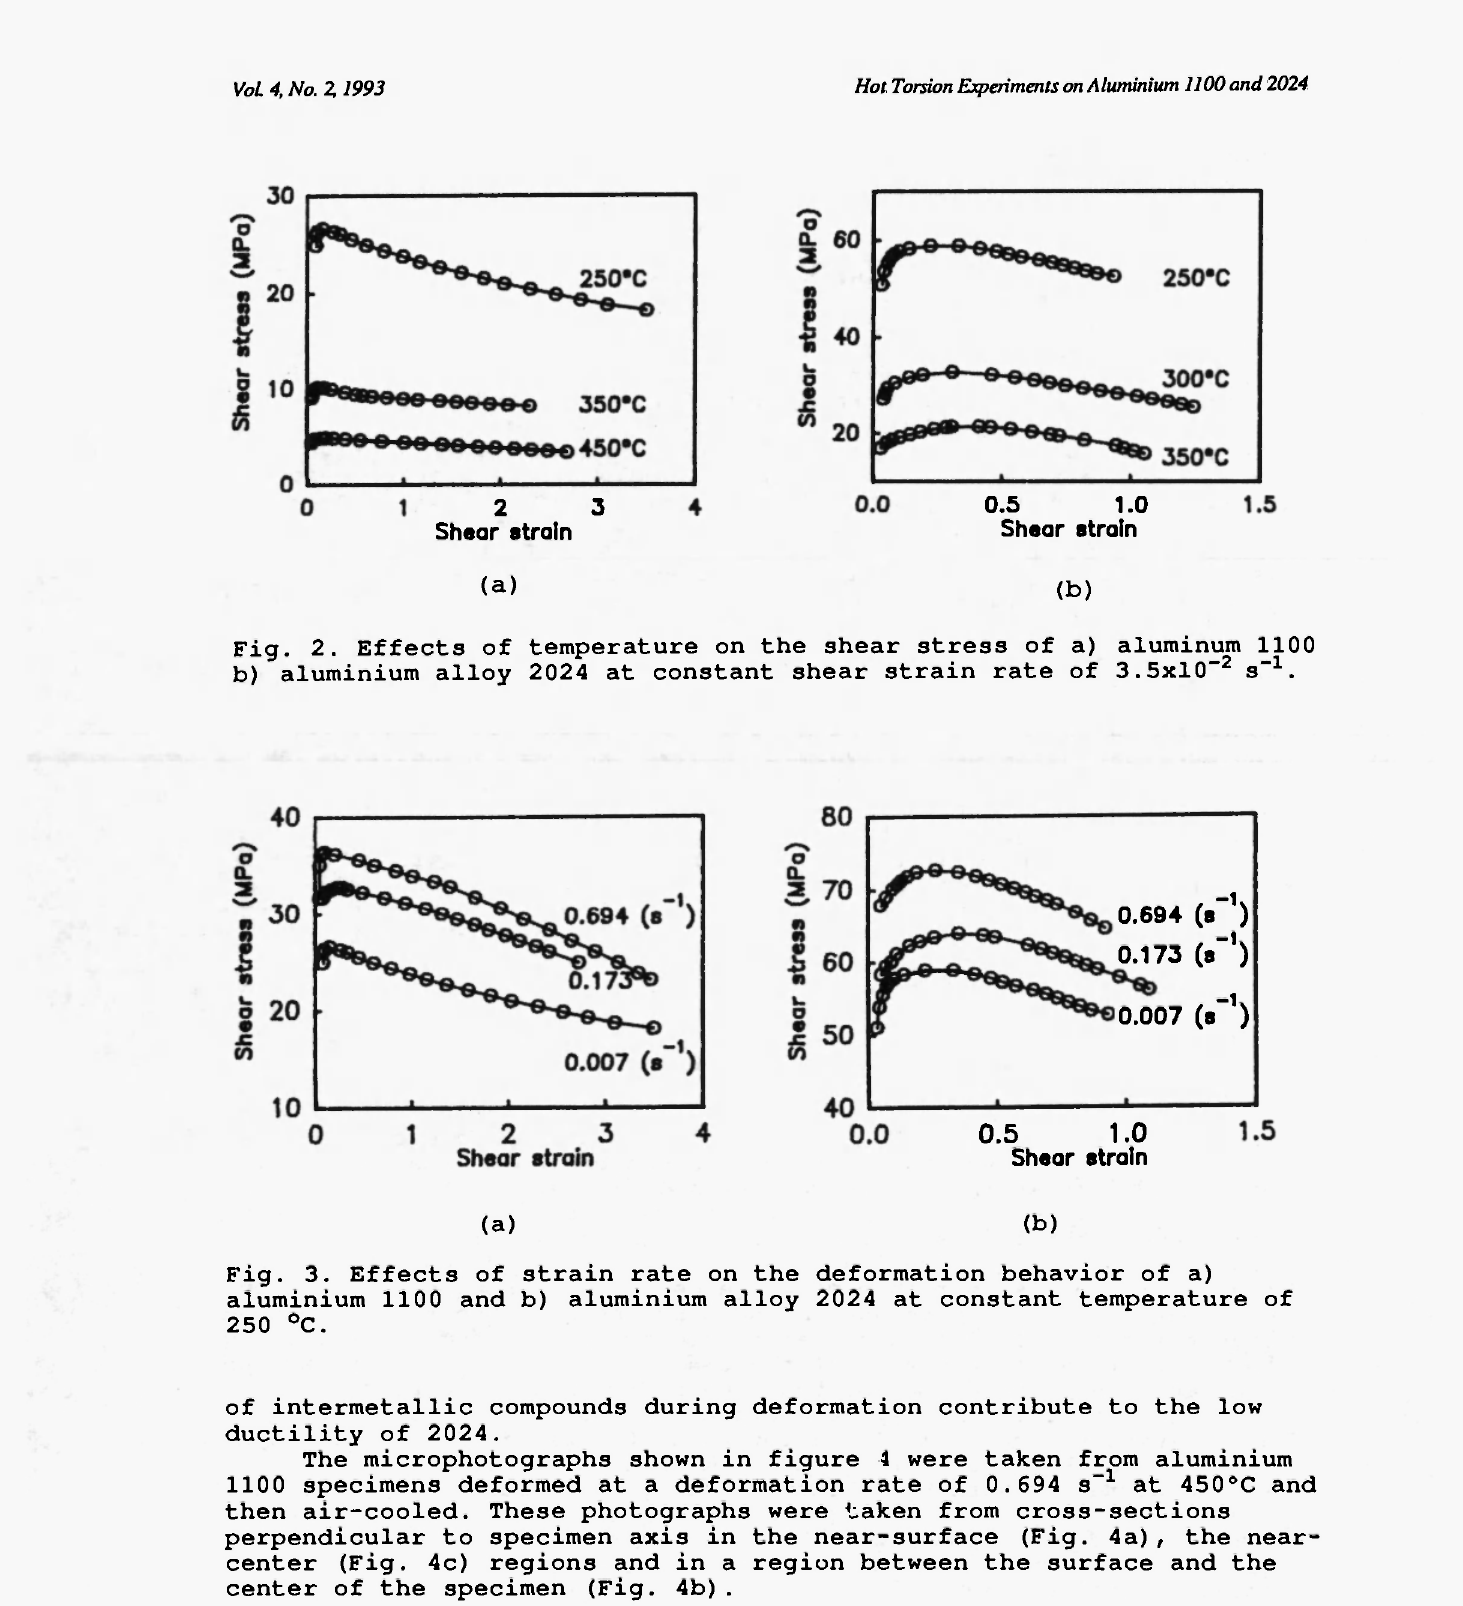
Fig. 3. Effects of strain rate on the deformation behavior of a) aluminium 1100 and b) aluminium alloy 2024 at constant temperature of 250